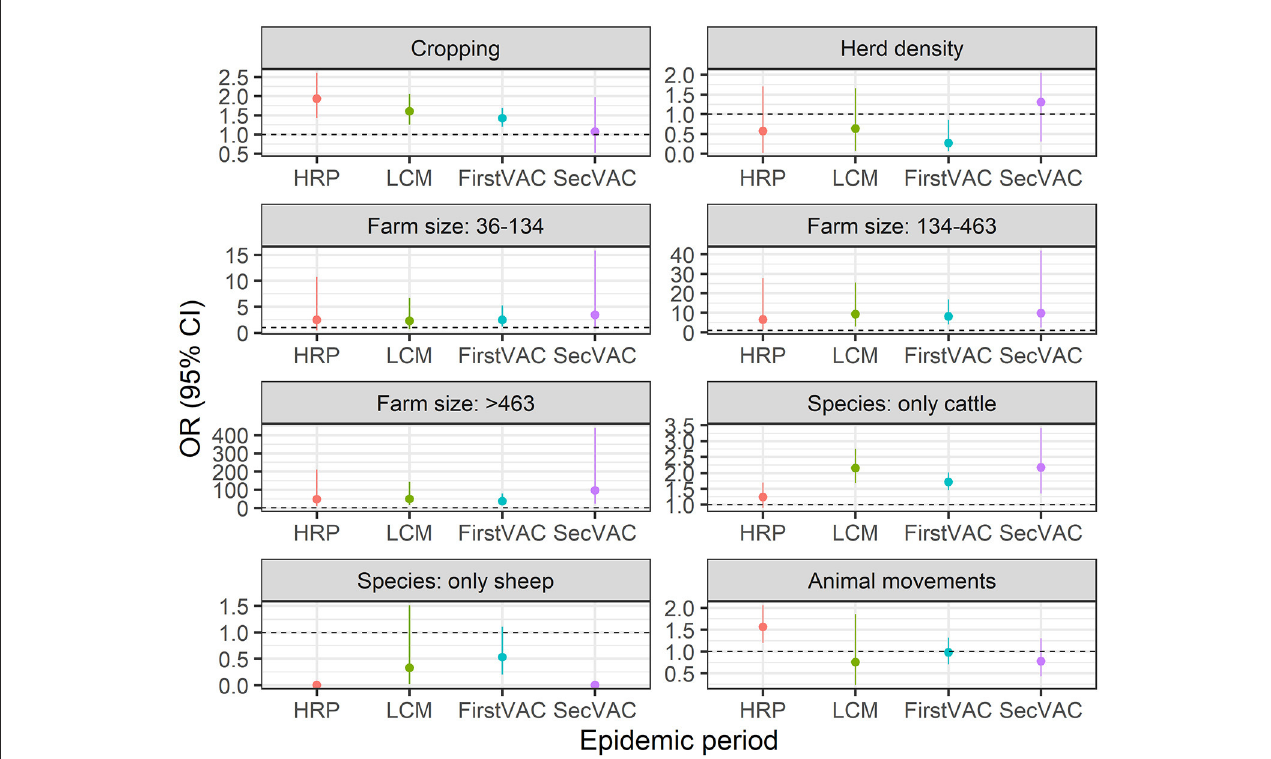
FIGURE5 Odds ratio (OR) of each explanatory variables for consecutive epidemic periods. HRP, the high-risk period; LCM, local control measures period; FirstVAC and SecVAC are the first (dose) mass vaccination round and second (dose) mass vaccination round. Reference levels for categorical variables are: (1) Cropping: Farms that did not combine livestock with crop production; (2) farm size: < 36 animals; (3) species: Farms that kept cattle and sheep (mixed); (4) animal movements: Farms without animal movements recorded. Regarding farm size variable, the estimated OR of “36–134” category was not significant for the HRP, LCM, and SecVAC periods, whereas was significant for the entire epidemic for categories “136–463” and “ > 463”.